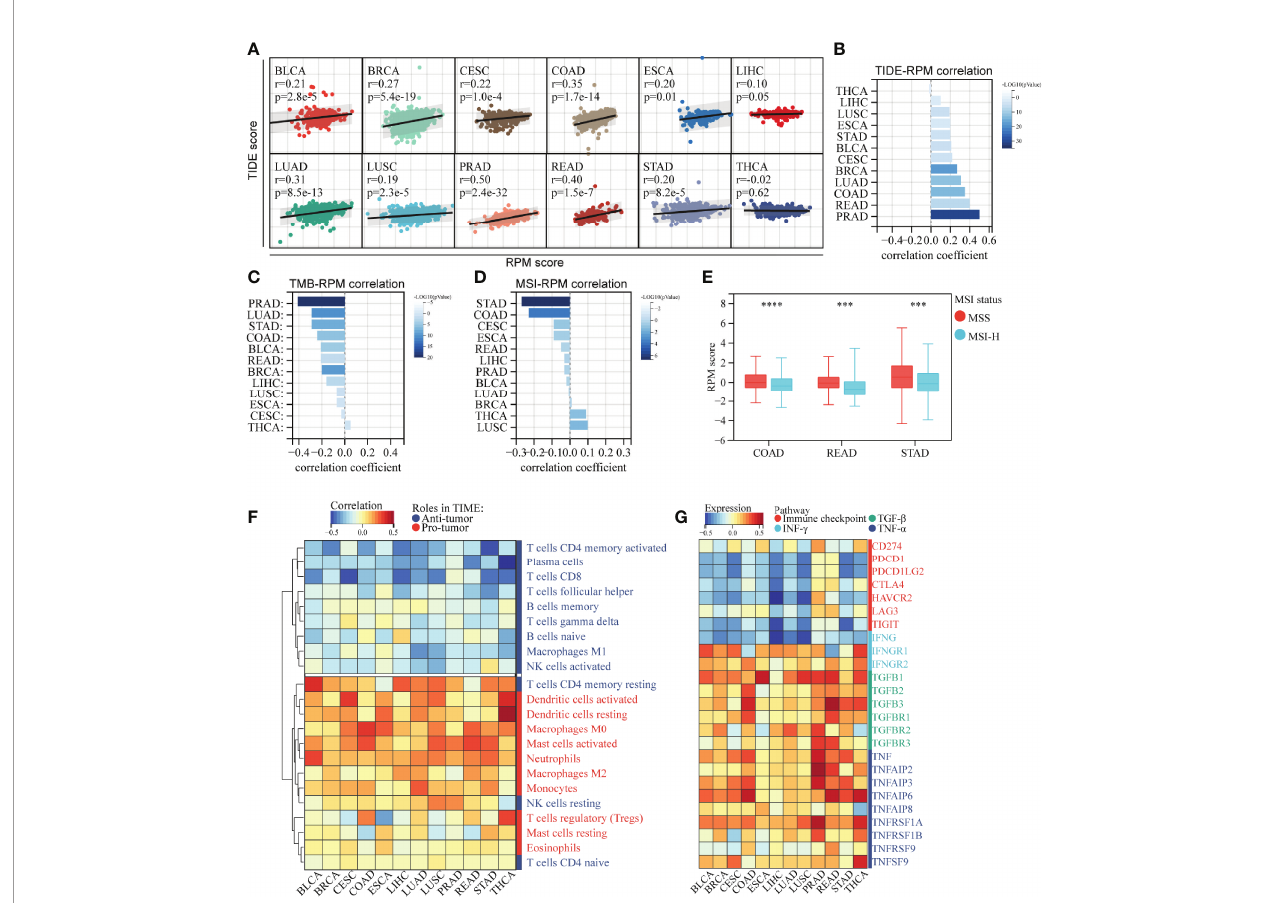
FIGURE 7 | RPM predicts immunotherapy response across multiple cancer types. (A, B) RPM scores were generally positively associated with TIDE scores across multiple cancer types. (C) RPM scores were generally negatively associated with TMB across multiple cancer types. (D) Correlation between RPM scores and MSI across multiple cancer types. (E) RPM scores were higher in patients with MSS than in those with MSI-H in COAD, READ, and STAD. (F) Correlation of RPM with density of in fi ltrating immune cells across 12 types of cancers. (G) Correlation of RPM with immune checkpoints, IFN- g , TGF- b , and TNF- a families across 12 types of cancers. *** P < 0.001, **** P < 0.0001; RPM, risk prediction model; TIDE, tumor immune dysfunction and exclusion; TMB, tumor mutation burden; MSI, microsatellite instability; MSS, microsatellite stability; COAD, colon cancer; READ rectal cancer; STAD, stomach cancer; IFN- g , interferon- g ; TGF- b , transforming growth factor- b ; TNF- a , tumor necrosis factor- a